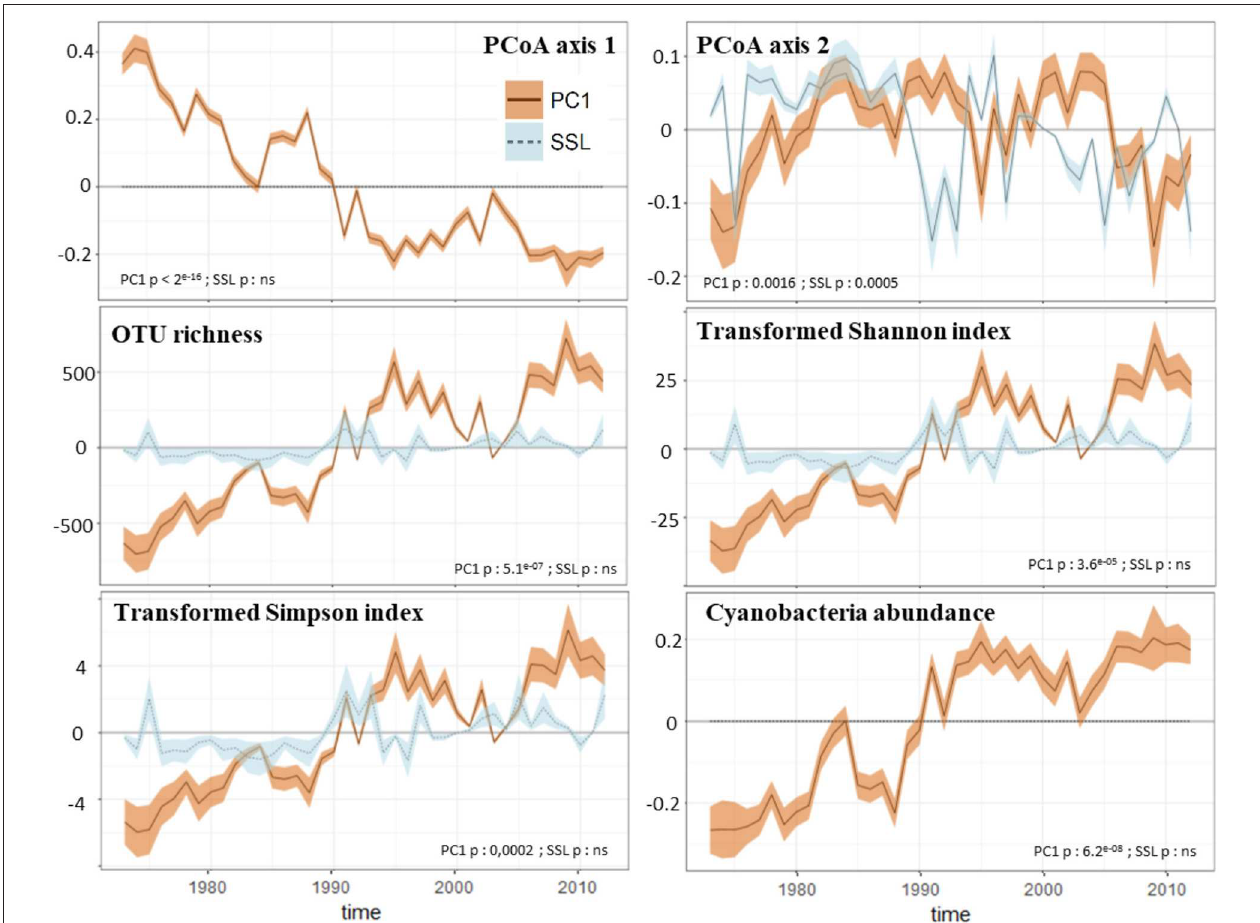
FIGURE 5 | GAMs analysis results of the microbial community. The figure presents the contribution (lines) of PC1 (PC1 geo -scores, brown values) and SSL (percentage of spring snow loss, light blue values) to the temporal changes in response variables. The shaded bands are 95% confidence intervals on the estimated effect. These intervals do not correct for multiple comparisons and have < 95% coverage over the whole time series. The response variables selected are structure indices of the protistan community (values of the first and second axes of the PCoA plot), diversity metrics of the protistan community (Hill’s numbers) and the Cyanobacteria abundance. Significant correlations with predictors are shown for each response